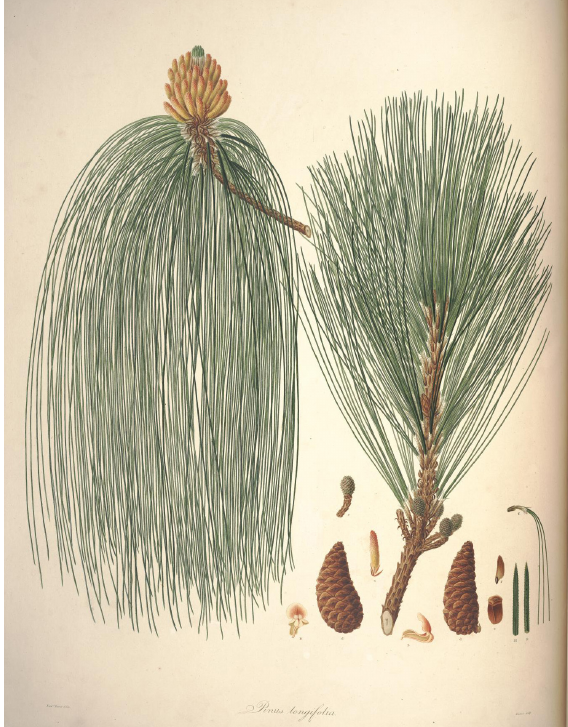
Image 3. Lectotype of Cedrus deodara : Lambert’s Tab. “Pinus